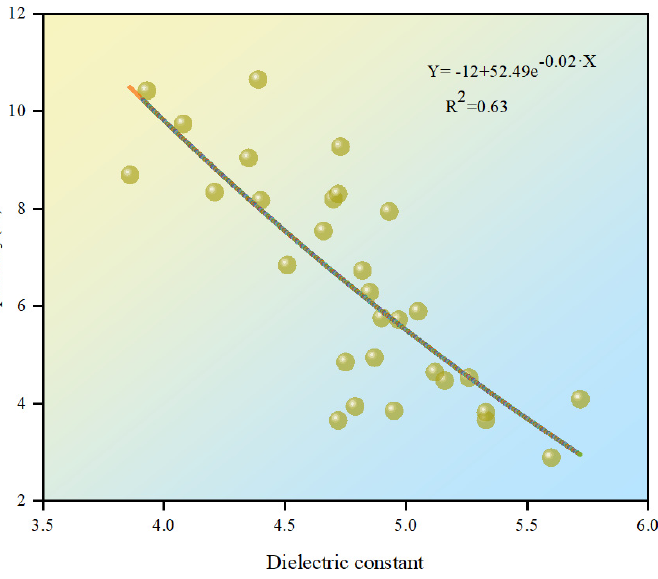
Figure 9. Fitting of the representative values of the dielectric constant obtained by Method 3 and the porosity.